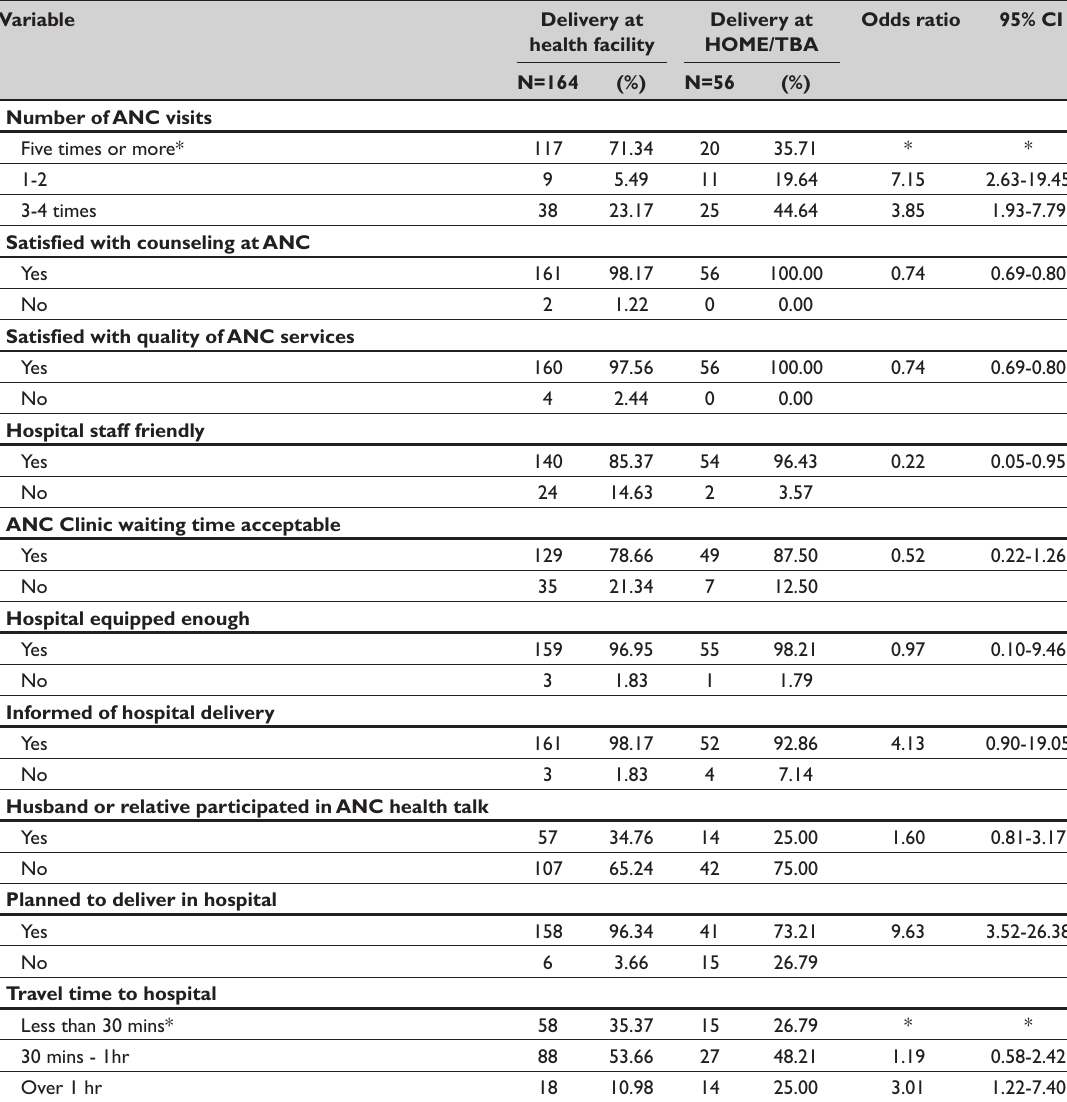
Table 2: Antenatal care visits and travel time on choice of health facility delivery